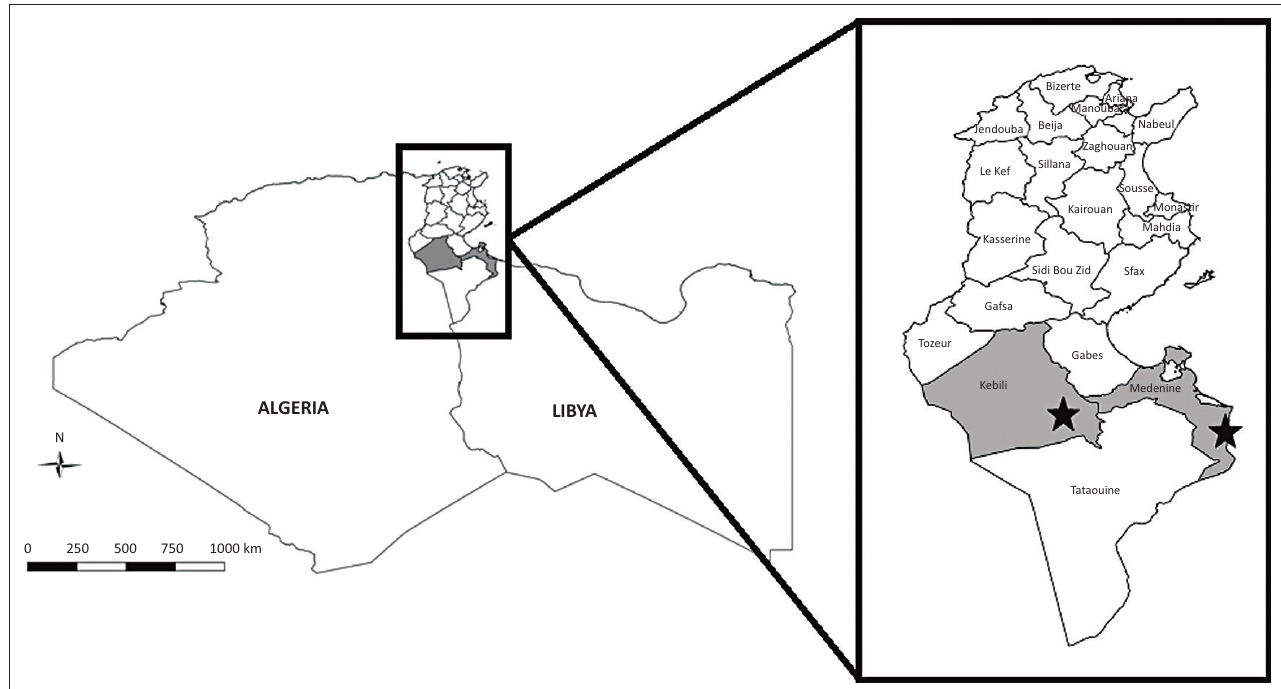
FIGURE 1: Geographical location of sampled dromedaries in the south of Tunisia (Kebili and Medenine